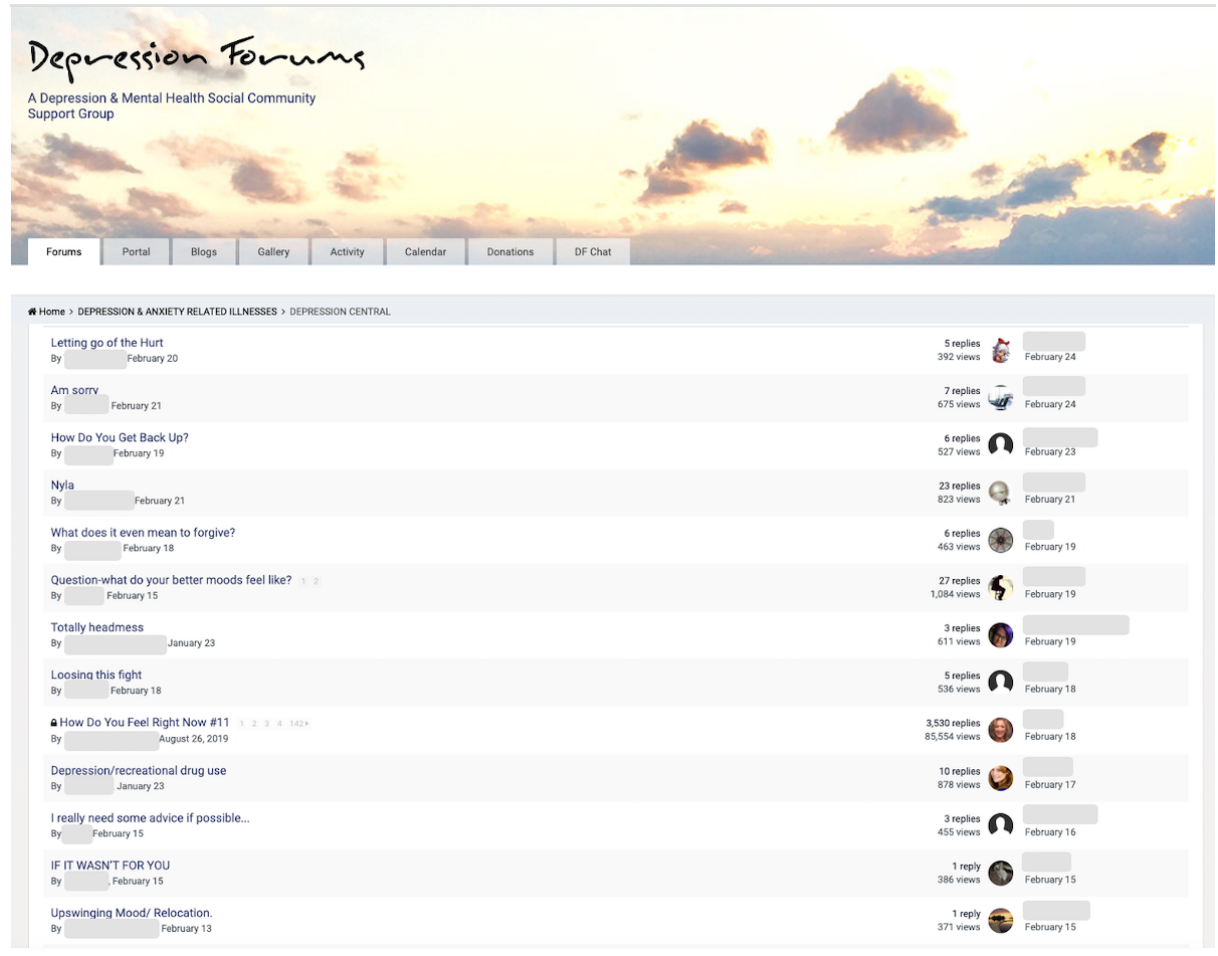
Figure 2. Screenshot of the depression forum’s threads. The virtual identities of the forum users are